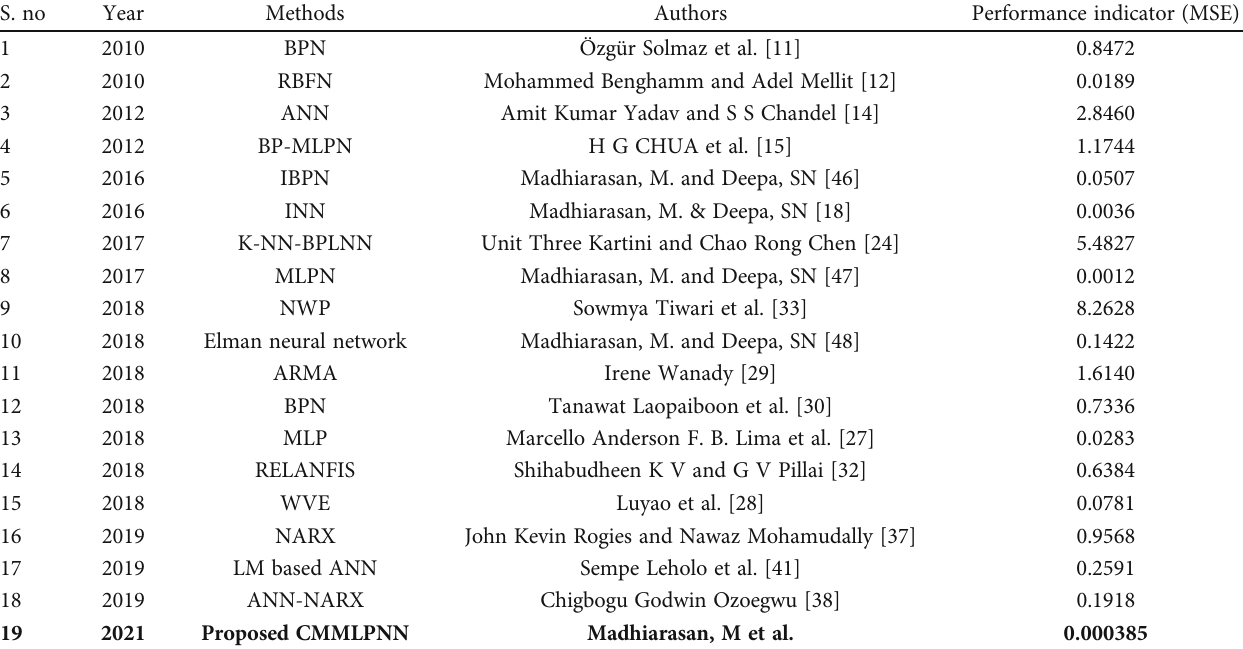
Table 9: Comparative analysis of di ff erent approach performances of the existing and proposed methods.